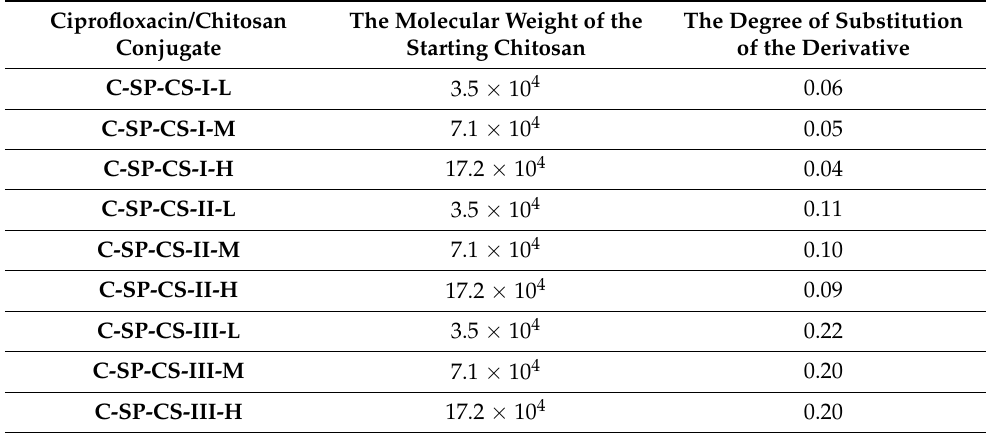
Table 4. Effect of ultrasonic irradiation on synthesis of ciprofloxacin conjugate with chitosan, contain- ing the pH sensitive spacer. Parameters, Identical for Both Ultrasound-Free and Ultrasonic Conditions DS T, ◦ C pH 0.05 25 ◦ C 3 0.9 3 h 0.5 20 min 0.10